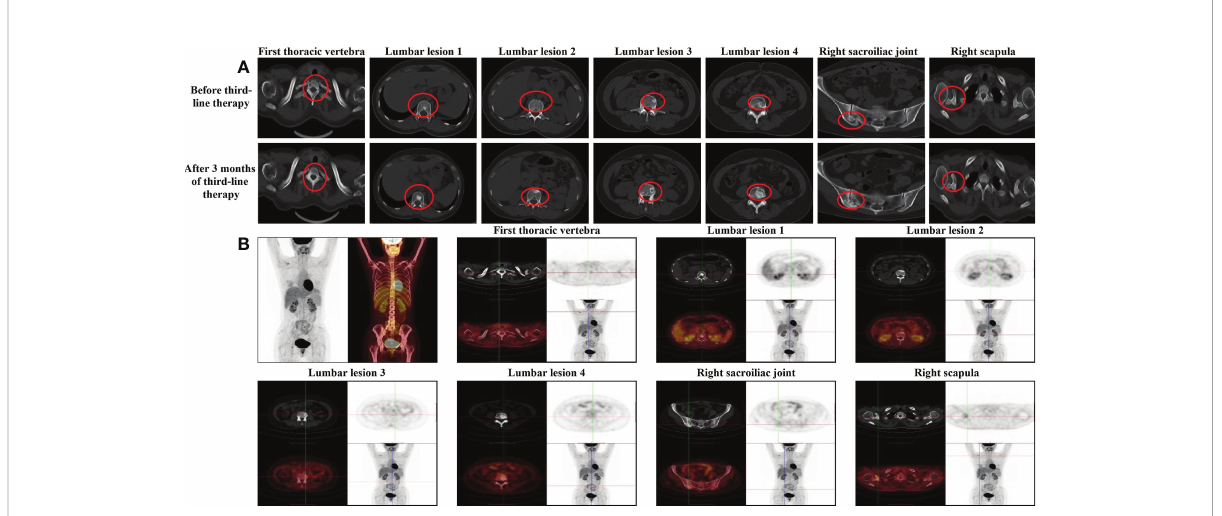
FIGURE 3 Imaging examinations during the third-line endocrine therapy (A) CT evaluation of the bone lesion after 3 months of third-line endocrme therapy in October 2021. (B) PET/CT evaluation of each bone lesion after 3 months of third-line endocrine therapy in October